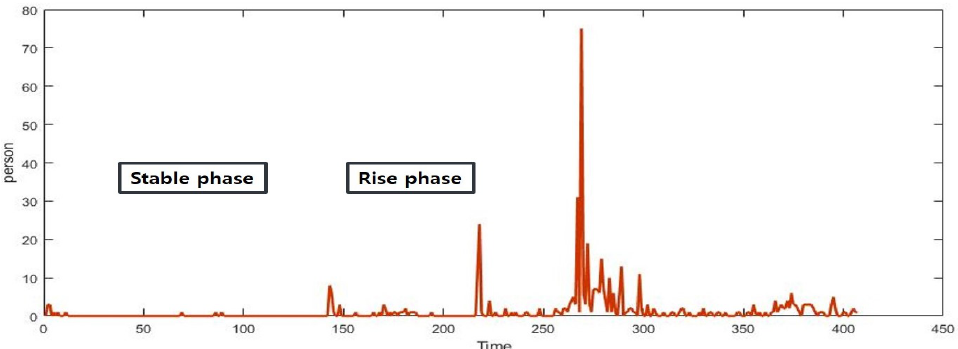
Figure 14. Real data on the number of infected person in CP (South